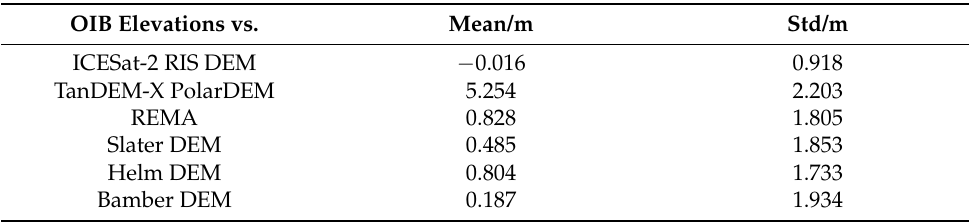
Table 7. Comparison between the six DEMs and OIB elevations in RIS. OIB Elevations vs. Mean/m Std/m